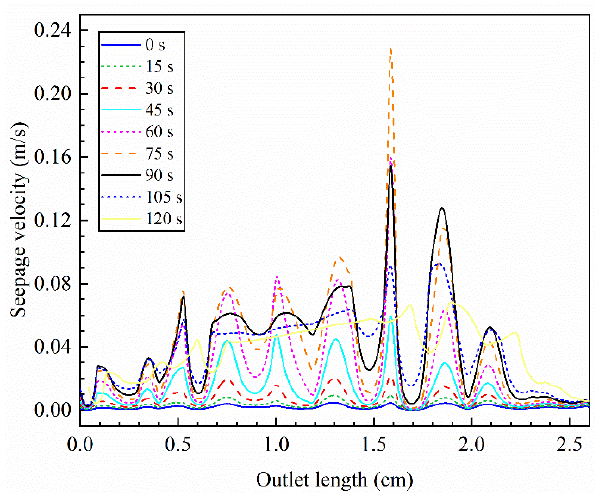
(cid:12) (cid:12) → (cid:12) (cid:12) (cid:12) (cid:12) q (cid:12) (cid:12) curves along the outlet boundary at di